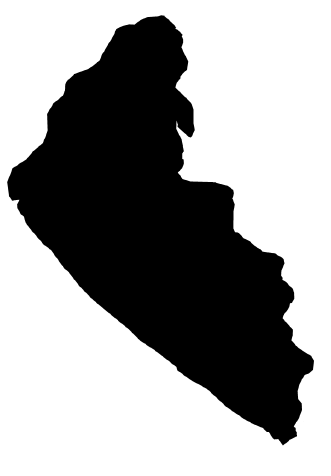
Figure 2. Model of the occupancy grid of Ypacarai